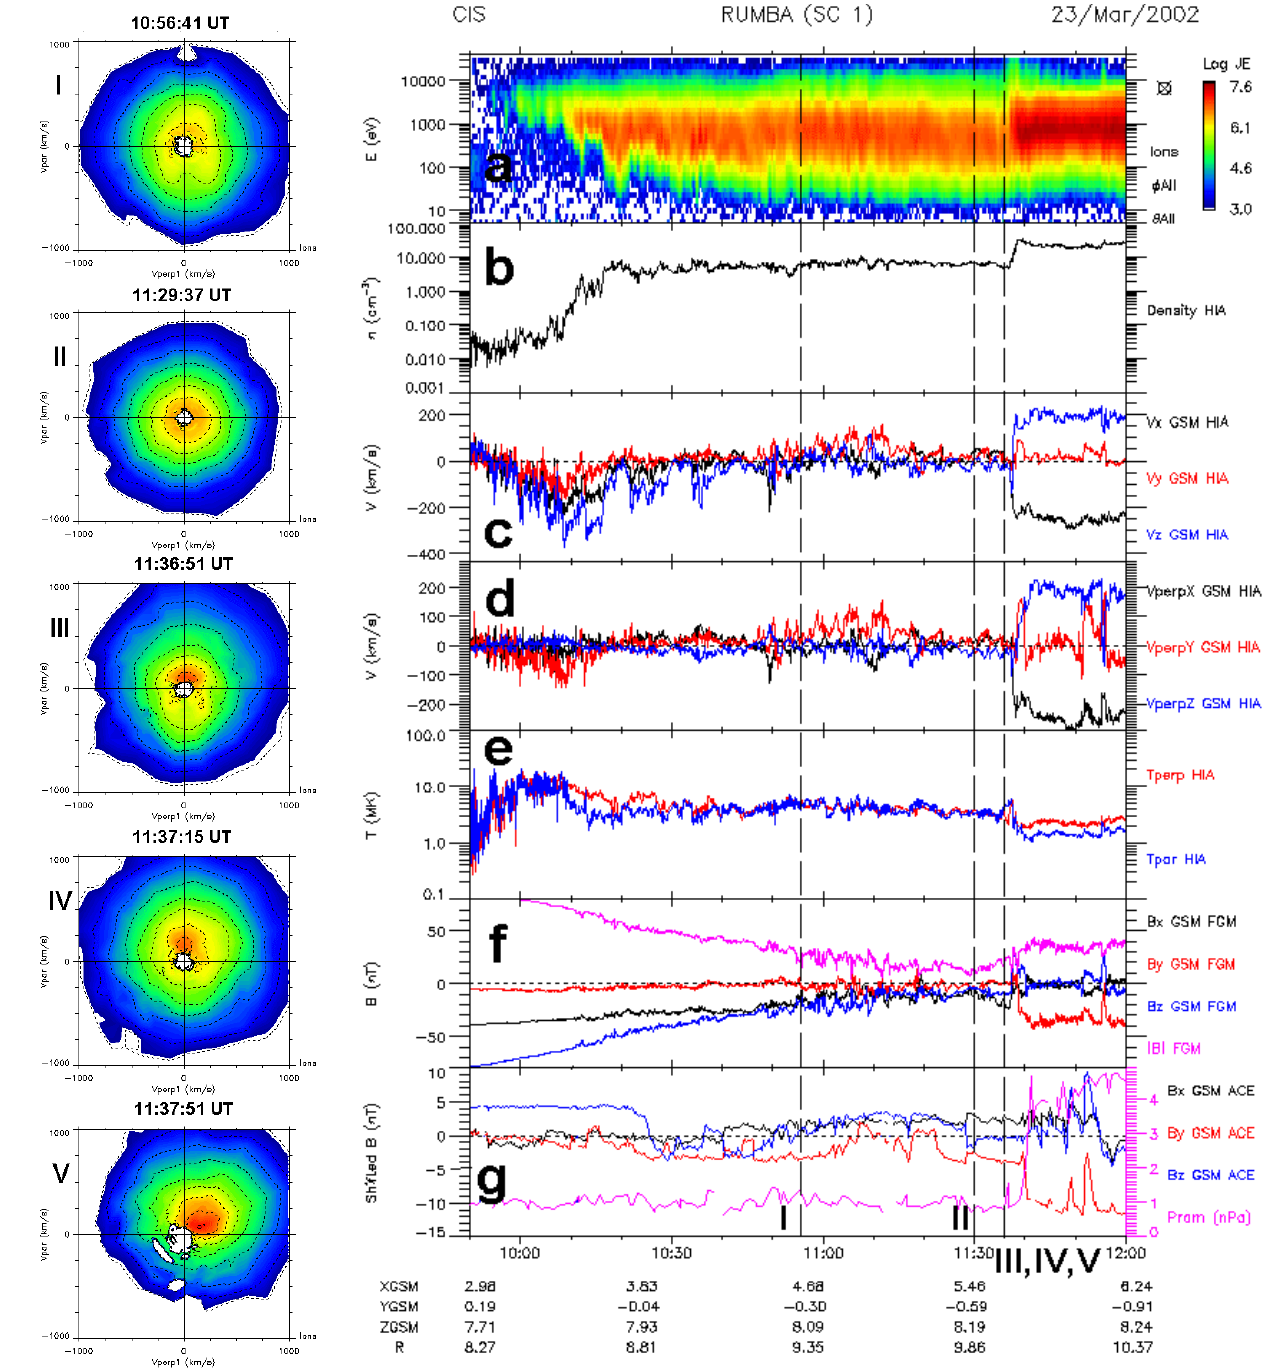
Fig. 4. Distributions and panel composer plot of Cluster data for the 23/03/2002 event. See the caption of Fig. 2. back to a radial orientation at 02:15 UT (with a weak B z com- ponent). This IMF turning is clearly correlated with FGM data in terms of the B z component (blue curve in panel (f)) when the spacecraft just exited in the magnetosheath (02:15– 02:20 UT). The SEC-magnetosheath boundary was therefore crossed prior to it, at 02:10